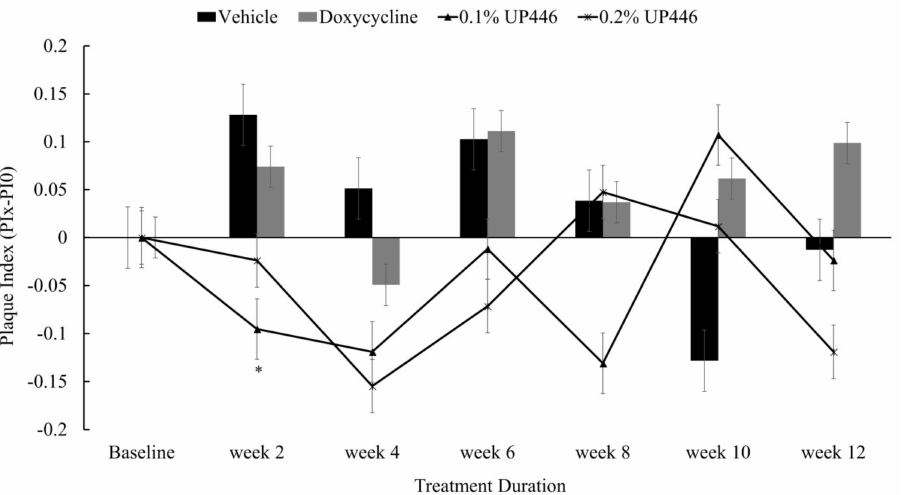
Figure 2. Changes in mean plaque indices in beagle dogs with ligature-induced periodontitis. Values are represented as di ff erences between before and after treatment. *; denote significance at p < 0.05 when compared with placebo and treated groups at the same